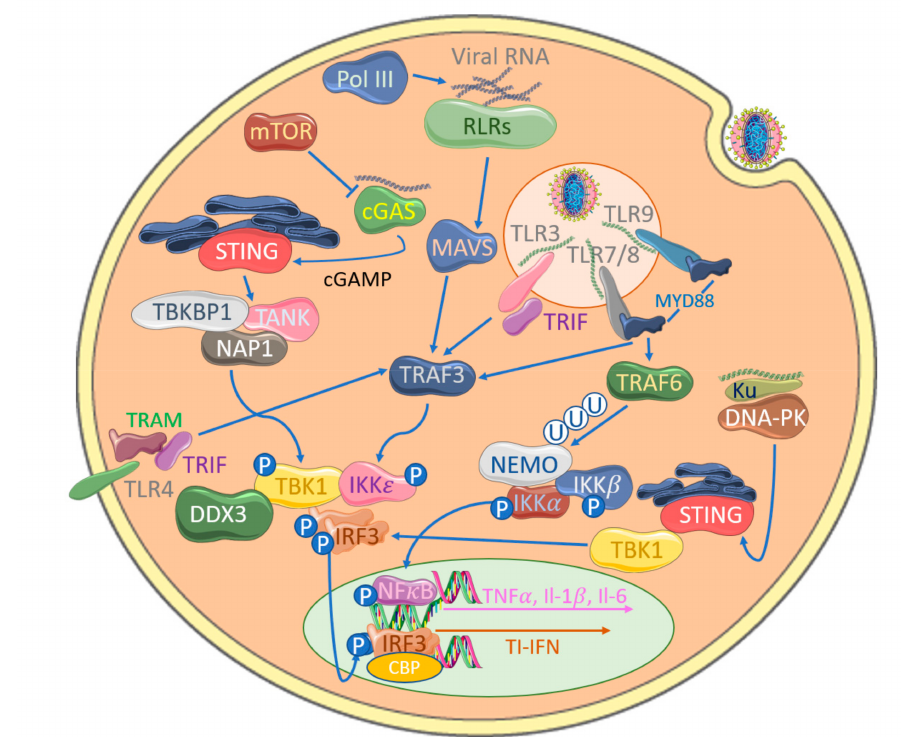
Figure 1. Detection of poxviruses by anti-viral pattern recognition receptors (PRRs) leads to the activation of IRFs. IRF3 phosphorylation by TBK1 and IKK ε leads to its dimerization and